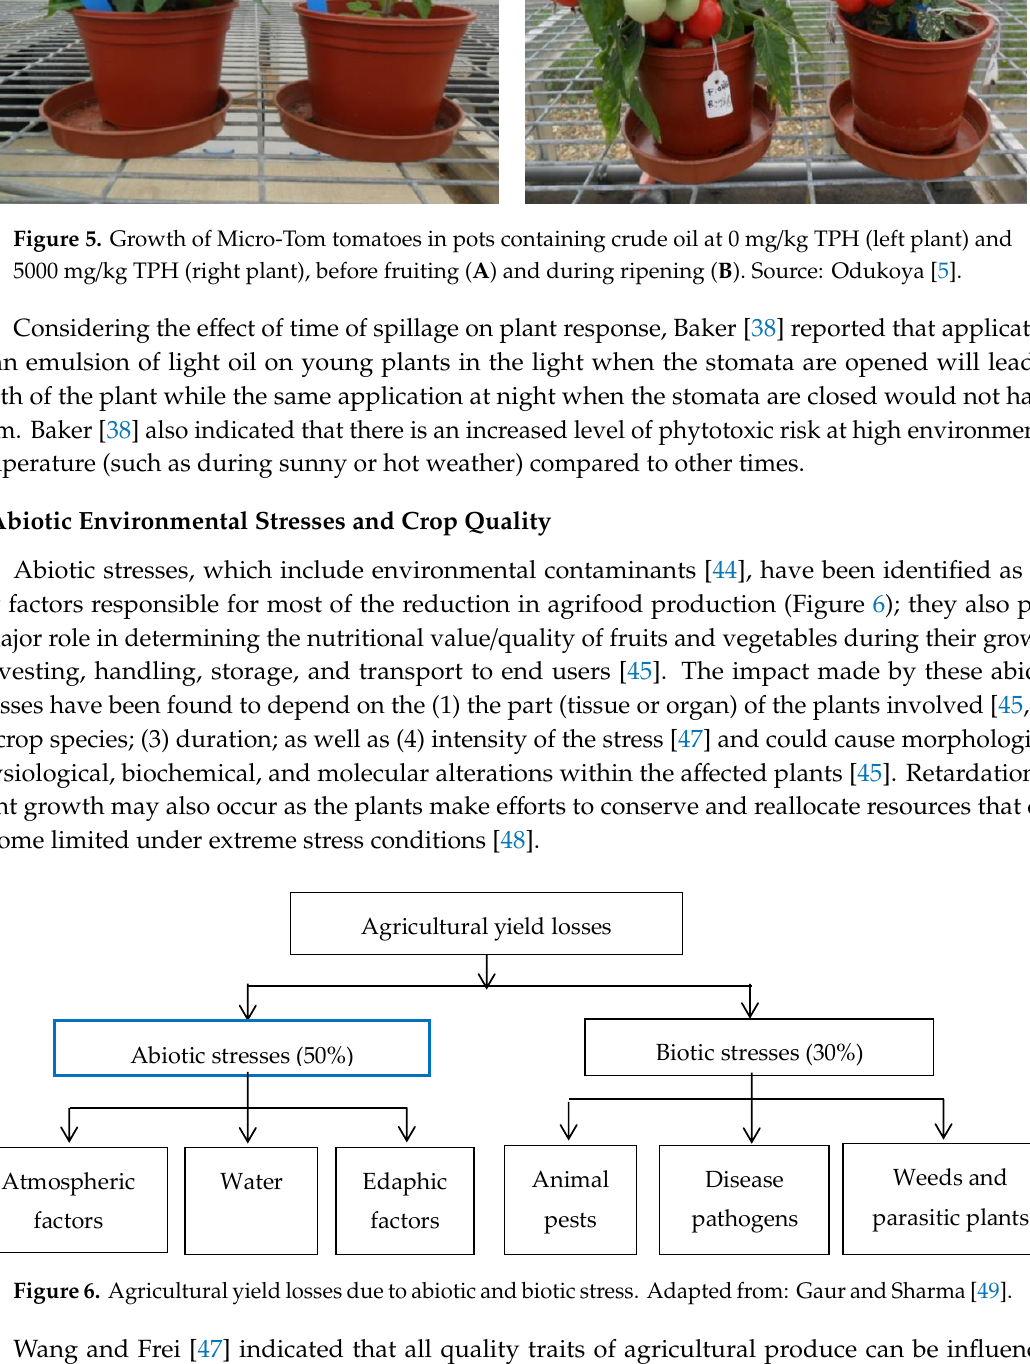
Figure 6. Agricultural yield losses due to abiotic and biotic stress. Adapted from: Gaur and Sharma [49].